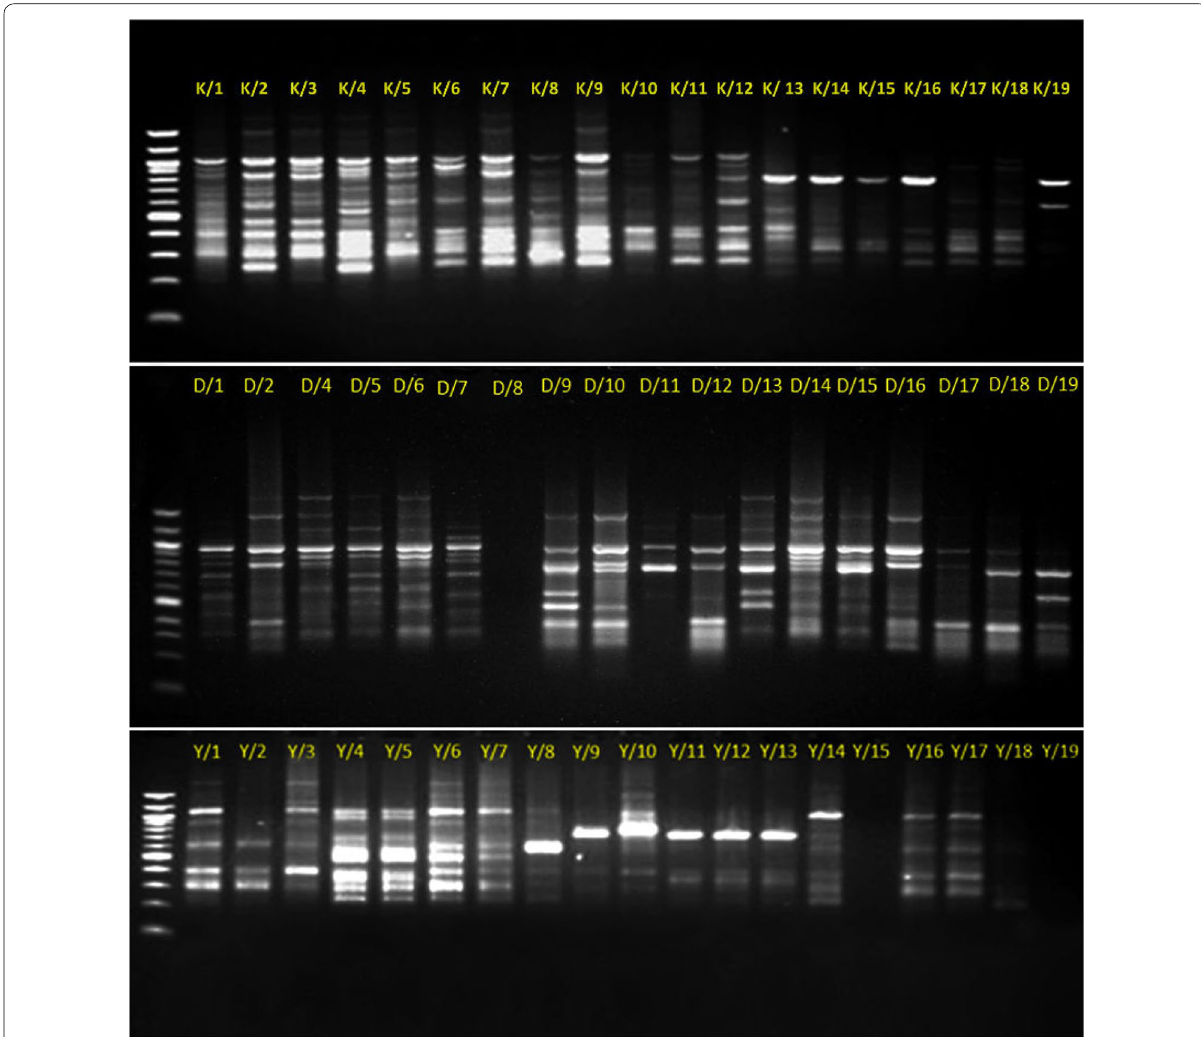
Fig. 8 DNA fingerprinting pattern generated by Inter‑Simple Sequence Repeats (ISSR) primers of 19 samples (K1–K19) of Blepharis from Kufranjah valley (upper image), 18 samples (D1–D19) from the Dead Sea region (middle image), and 19 samples (Y1–Y19) from Wadi al Yutm (lower image). Amplification products were obtained using UBC 848 primer. Accession numbers of each individual are provided at the top of the gel images. D3 accession sample was removed because it showed some discrepancies suggesting the presence of an